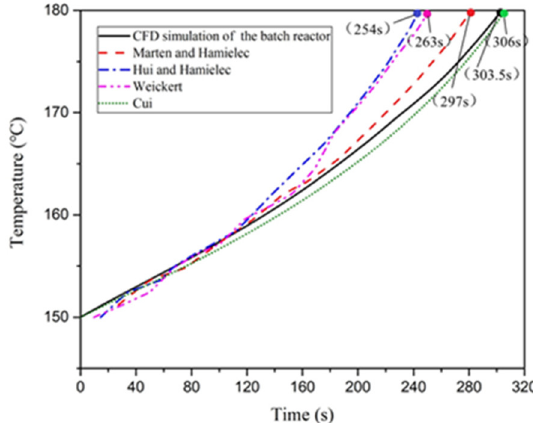
Figure 4. Predicted temperature curve of styrene polymerization, by the computation fluid dynamics (CFD) model and comparative model.